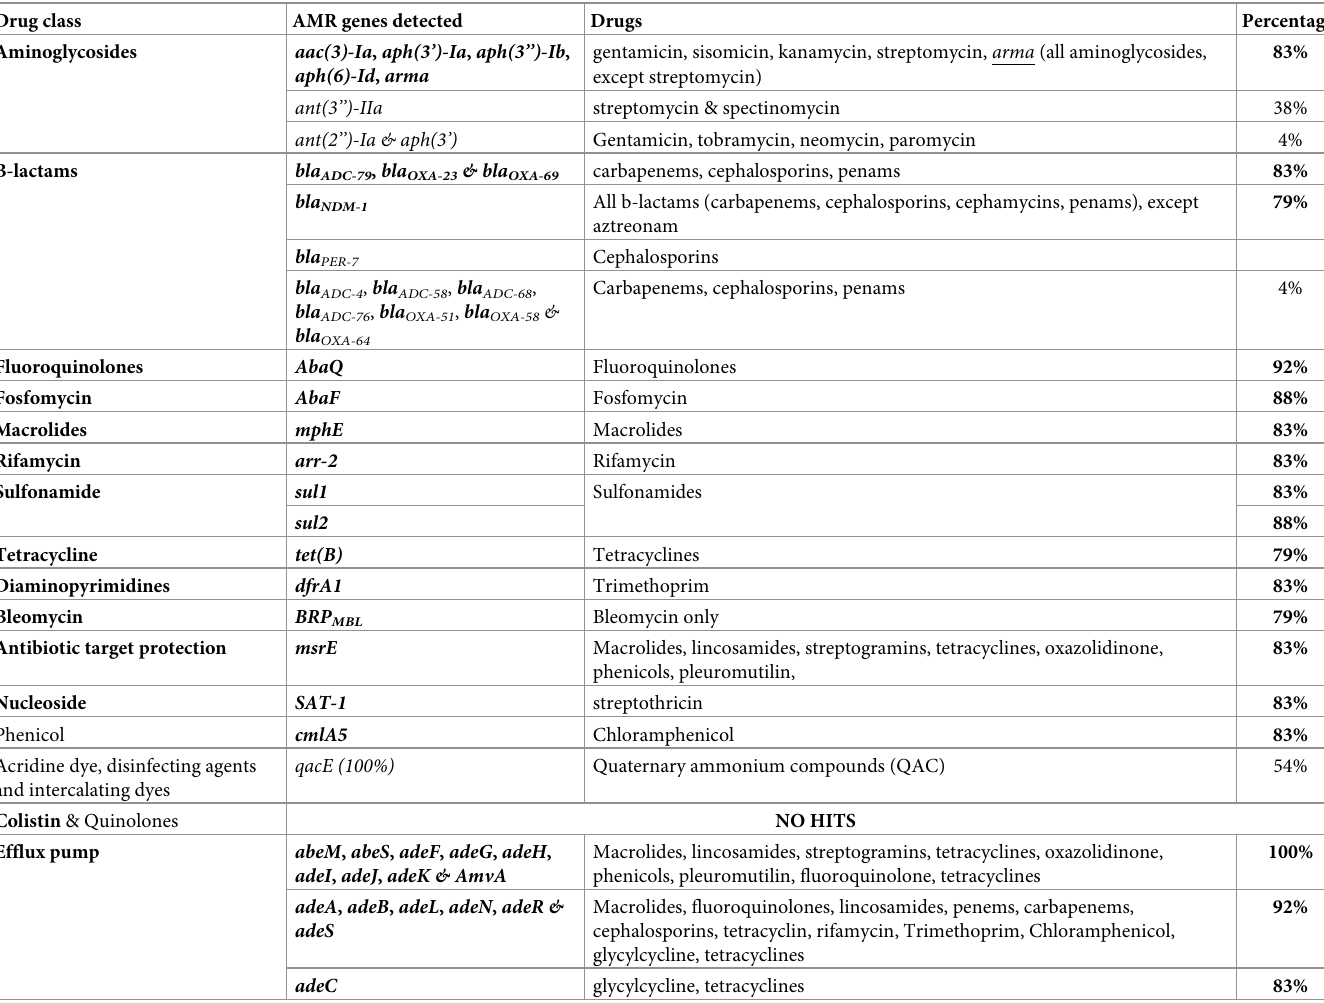
Table 5. Summary of resistance genes present in the colistin-resistant Acinetobacter baumannii isolates per drug class (n =